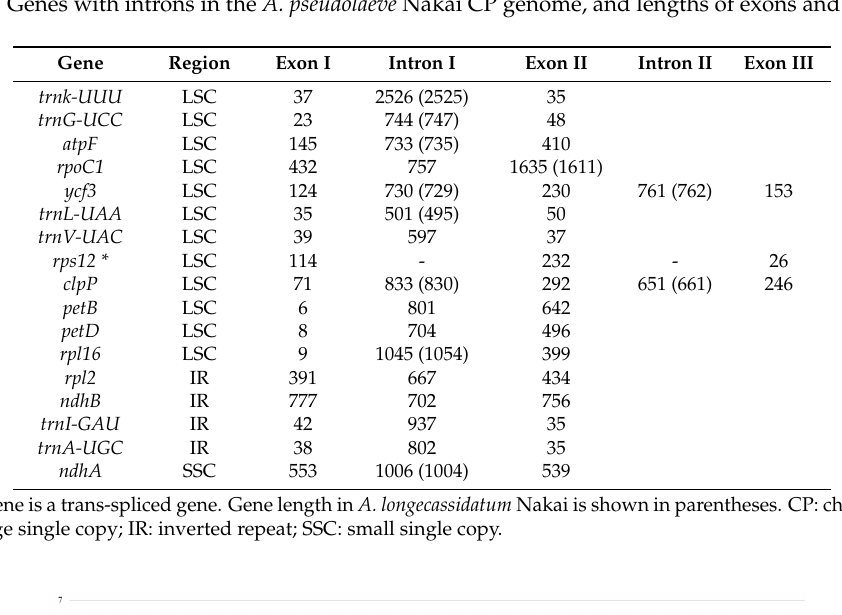
Table 3. Genes with introns in the A. pseudolaeve Nakai CP genome, and lengths of exons and introns.